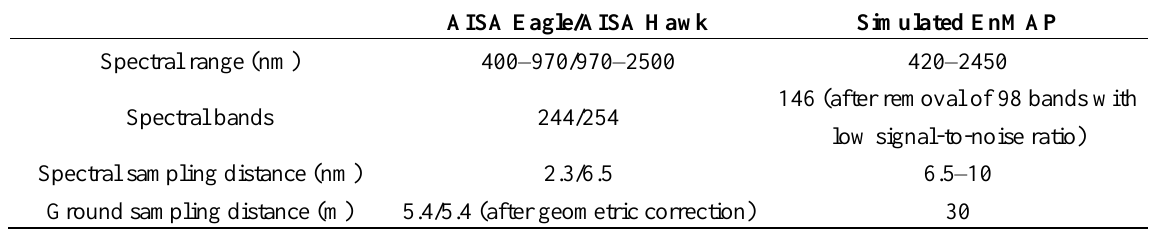
Table 1. Spectral configurations and spatial properties for EnMAP simulation input and